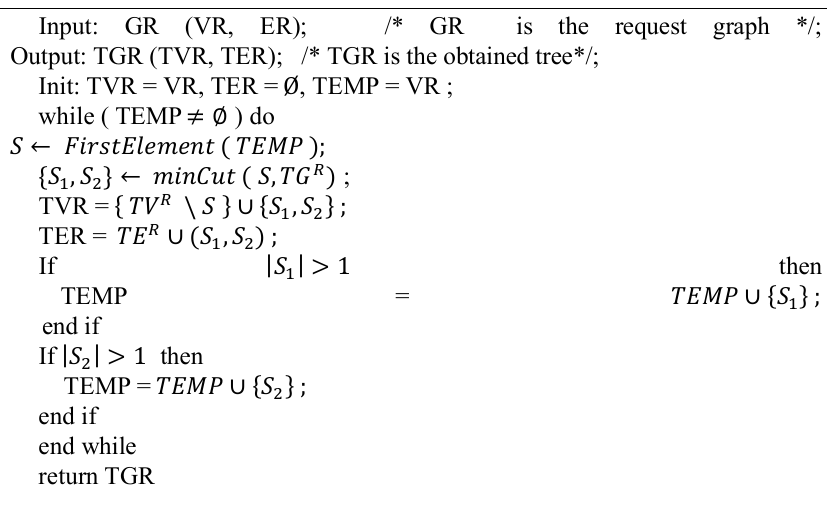
Algorithm 1: Gomory-Hu Tree Construction